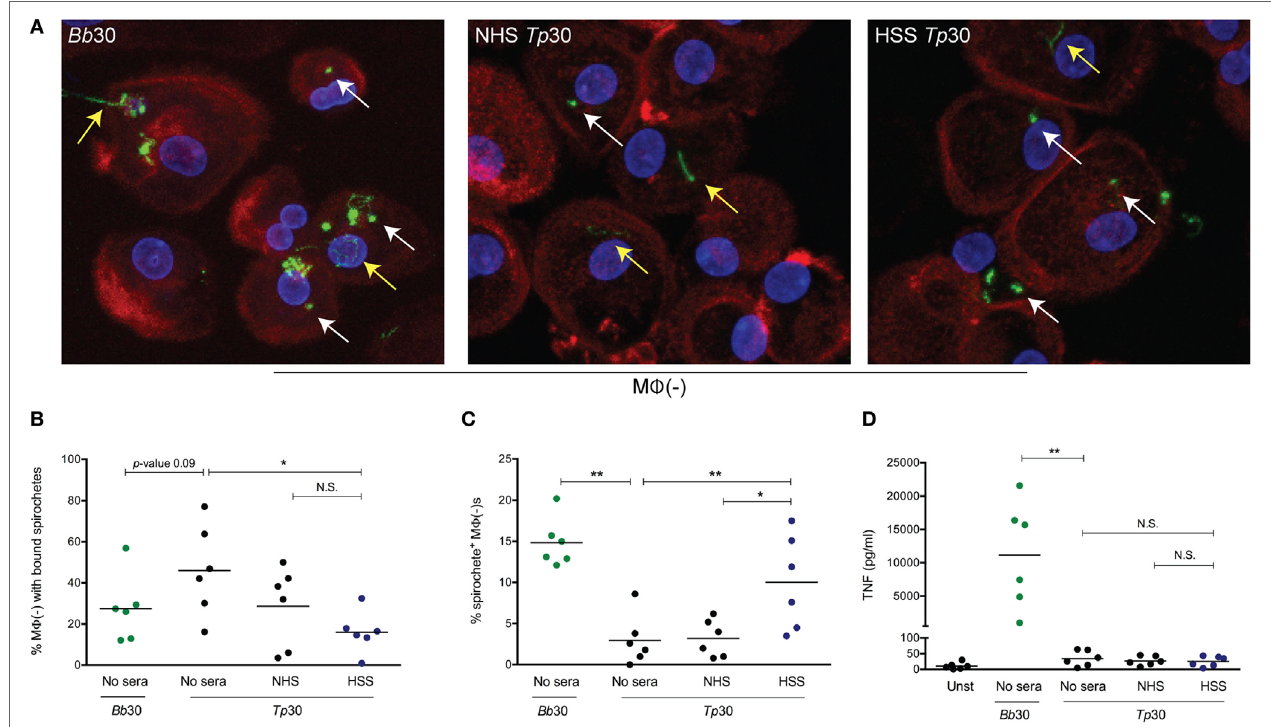
FigUre 2 | Spirochetal uptake and cytokine secretion by primary human macrophages. Monocyte-derived macrophages [depicted as M Φ ( − )], matured with 20% normal human serum (NHS) were stimulated with Borrelia burdorferi ( Bb) or Treponema pallidum ( Tp) at an multiplicity of infection (MOI) 30:1 for 8 h. Tp were incubated alone (no sera) or, where indicated, with 10% heat inactivated NHS or human syphilitic serum (HSS). (a) Macrophage actin cytoskeleton (red), nucleus (blue), and Bb or Tp (green) were labeled and imaged as described in Section “Materials and Methods.” Representative confocal micrographs demonstrating binding (yellow arrow) and internalization (white arrow) of spirochetes are shown as 20 consecutive compressed Z-stack panels. Dot plot in (B) shows percentage of M Φ ( − )s with surface bound spirochetes in four conditions, Bb alone and Tp with no sera, NHS, or HSS. Dot plot in (c) reveals the percentage of M Φ ( − )s containing internalized Bb and Tp in the presence of HSS (blue circles) when compared to no sera and NHS (black circles). Dot plot in (D) reveals supernatant TNF concentration (pg/ml) for M Φ ( − )s stimulated with Bb (green circles) and Tp under three different conditions. Statistical significance between Bb and no Sera Tp was determined by two-tailed Mann–Whitney test. The statistical significance between the three Tp conditions was determined by Friedman’s test with a Dunnett’s multiple comparison post-test analysis. N.S., not significant, * p -value of < 0.05, ** p -value of < 0.01.